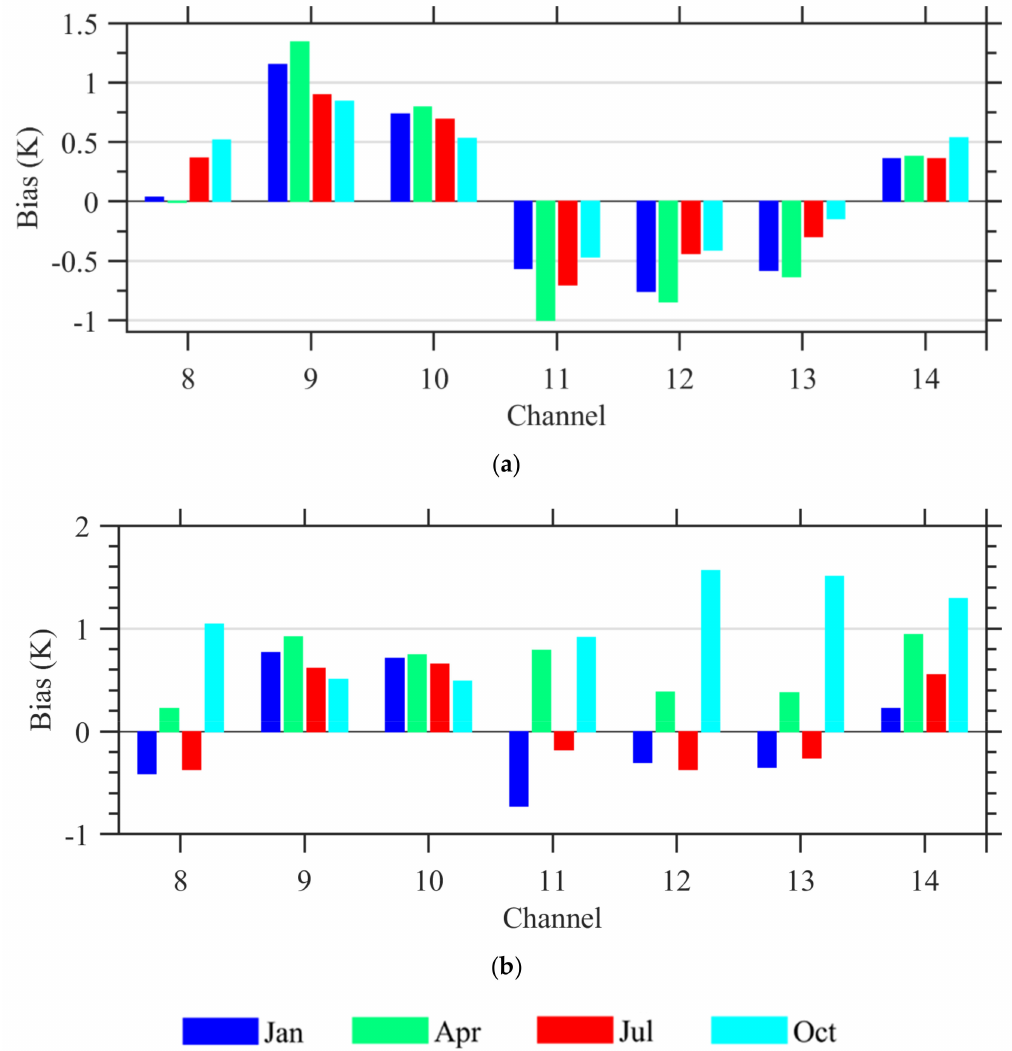
Figure 9. Monthly mean biases of AGRI bands 8–14, calculated by OMB FNL statistics for data ( a ) over the ocean and ( b ) over land in January, April, October, and July